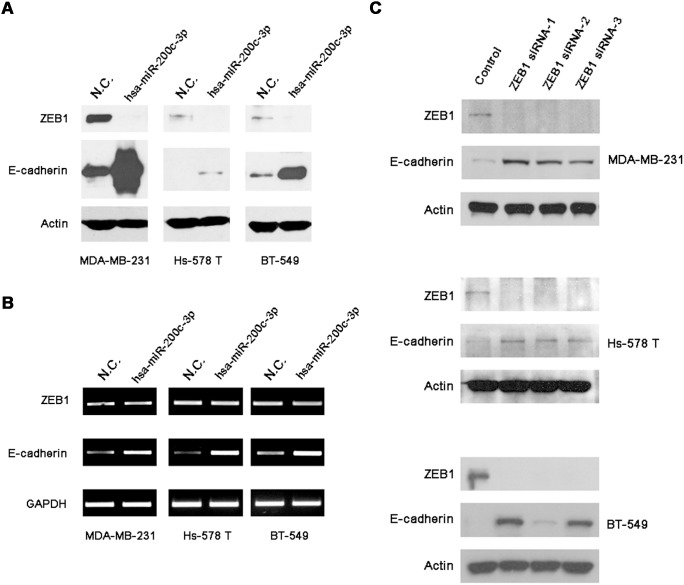
miR-200c/ZEB1/E-cadherin signal pathway regulates the epithelial-to-mesenchymal transition in breast cancer cells.Re-expression of miR-200c in breast cancer cells results in up-regulation of E-cadherin expression and the down-regulation of ZEB1 expressions as assessed by using Western Blot analysis (A) and RT-PCR (B). siRNA knockdown of the expressions of ZEB1 results in up-regulation of E-cadherin expression in breast cancer cells (C).